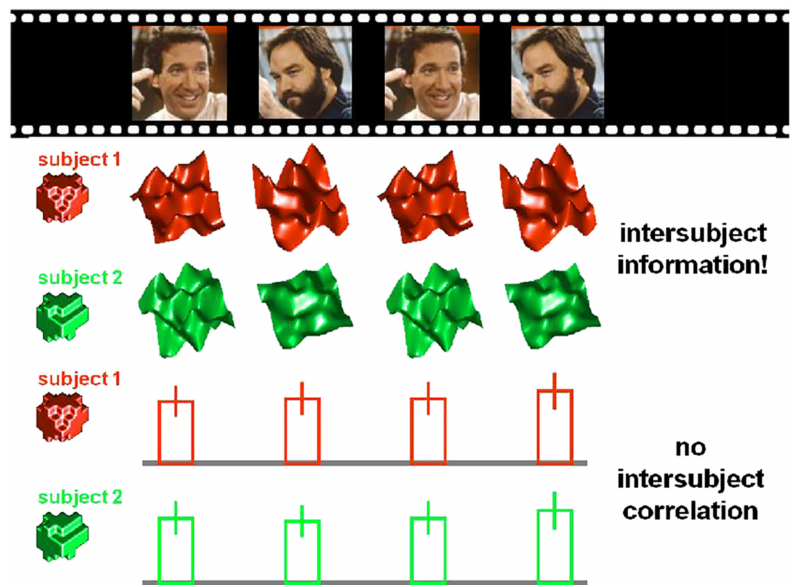
Figure 3 . Intersubject information does not imply intersubject correlation. A given brain region in two subjects (red, green) can encode the same information about a common stimulus stream (television clip at the top), even if the spatial brain-activity patterns encoding the information differ between the subjects, and even if the regional-average activation is constant across time or uncorrelated between the